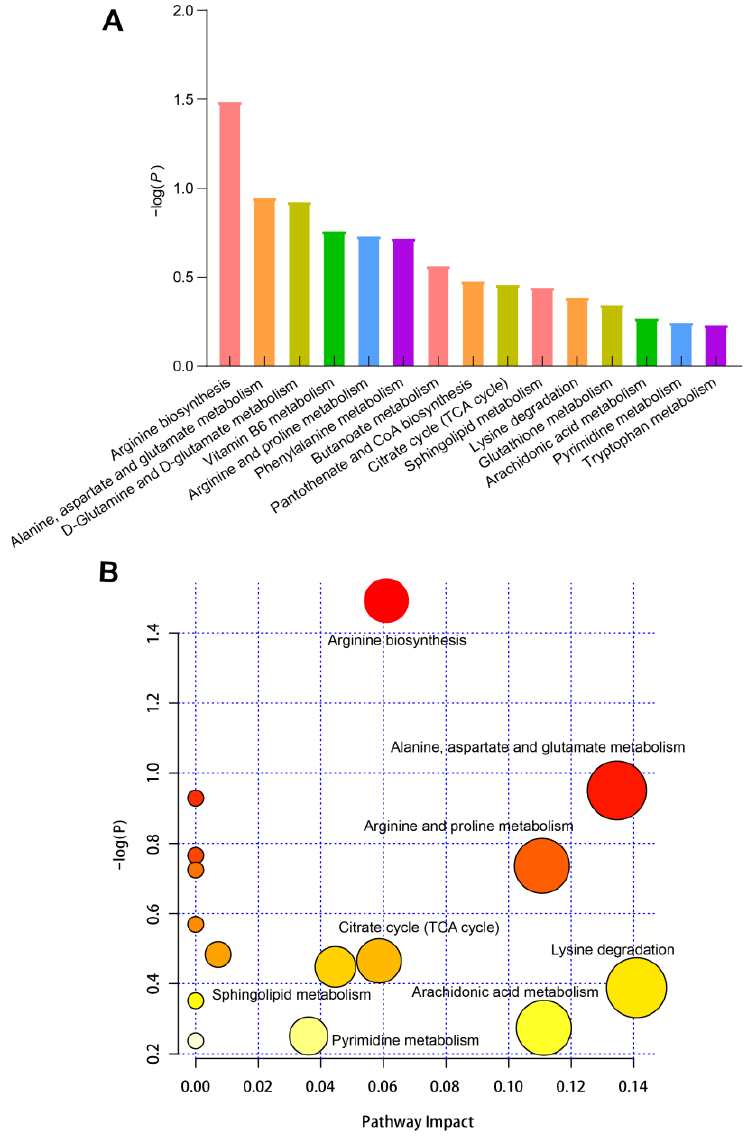
Figure 6. Kyoto Encyclopedia of Genes and Genomes (KEGG) enrichment analysis of differential metabolites in the plasma. ( A ) Bar graphs of the top fifteen most enriched metabolic pathways. ( B ) Bubble plot of top most enriched pathways. Dot size and color shade are positively related to the impact on the respective metabolic